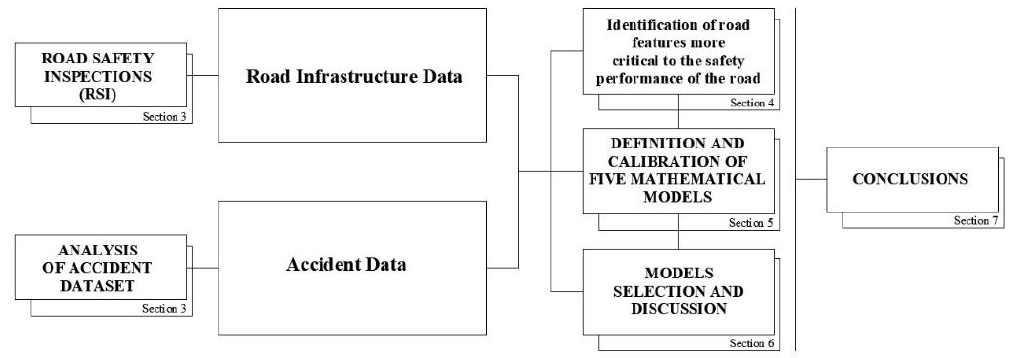
Figure 1. Chart showing the main activities.